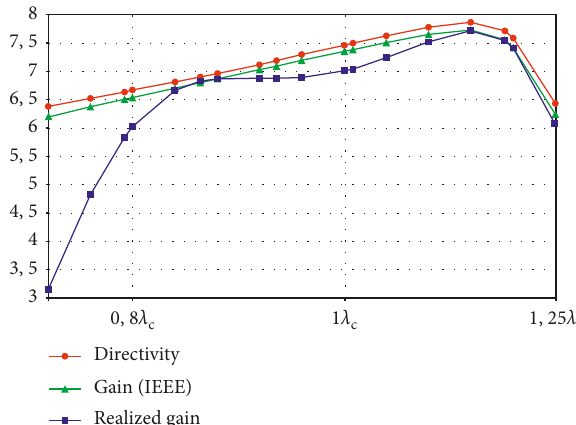
Figure 8: Directivity, intrinsic gain, and realized gain evolutions as a function of